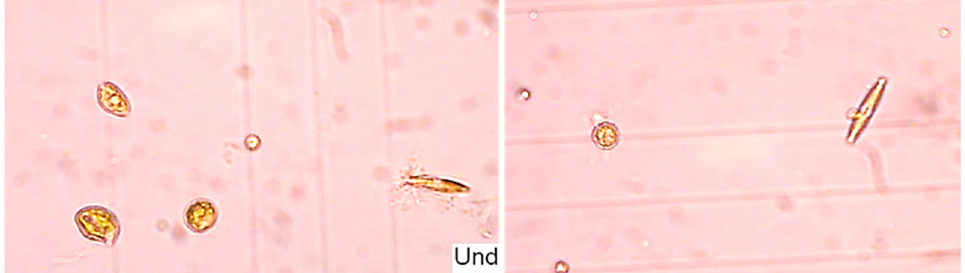
Figure 3. Microscopic observations (40×) of UWW autochthonous microalgal species detected in the C − PBR. Table 2. Growth parameters determined for each PBR: CV ( C. vulgaris + UWW), C+ ( C. vulgaris + autoclaved UWW), and C − (raw UWW). Values with a common superscript letter and within the same column are not statistically different ( p > 0.05).